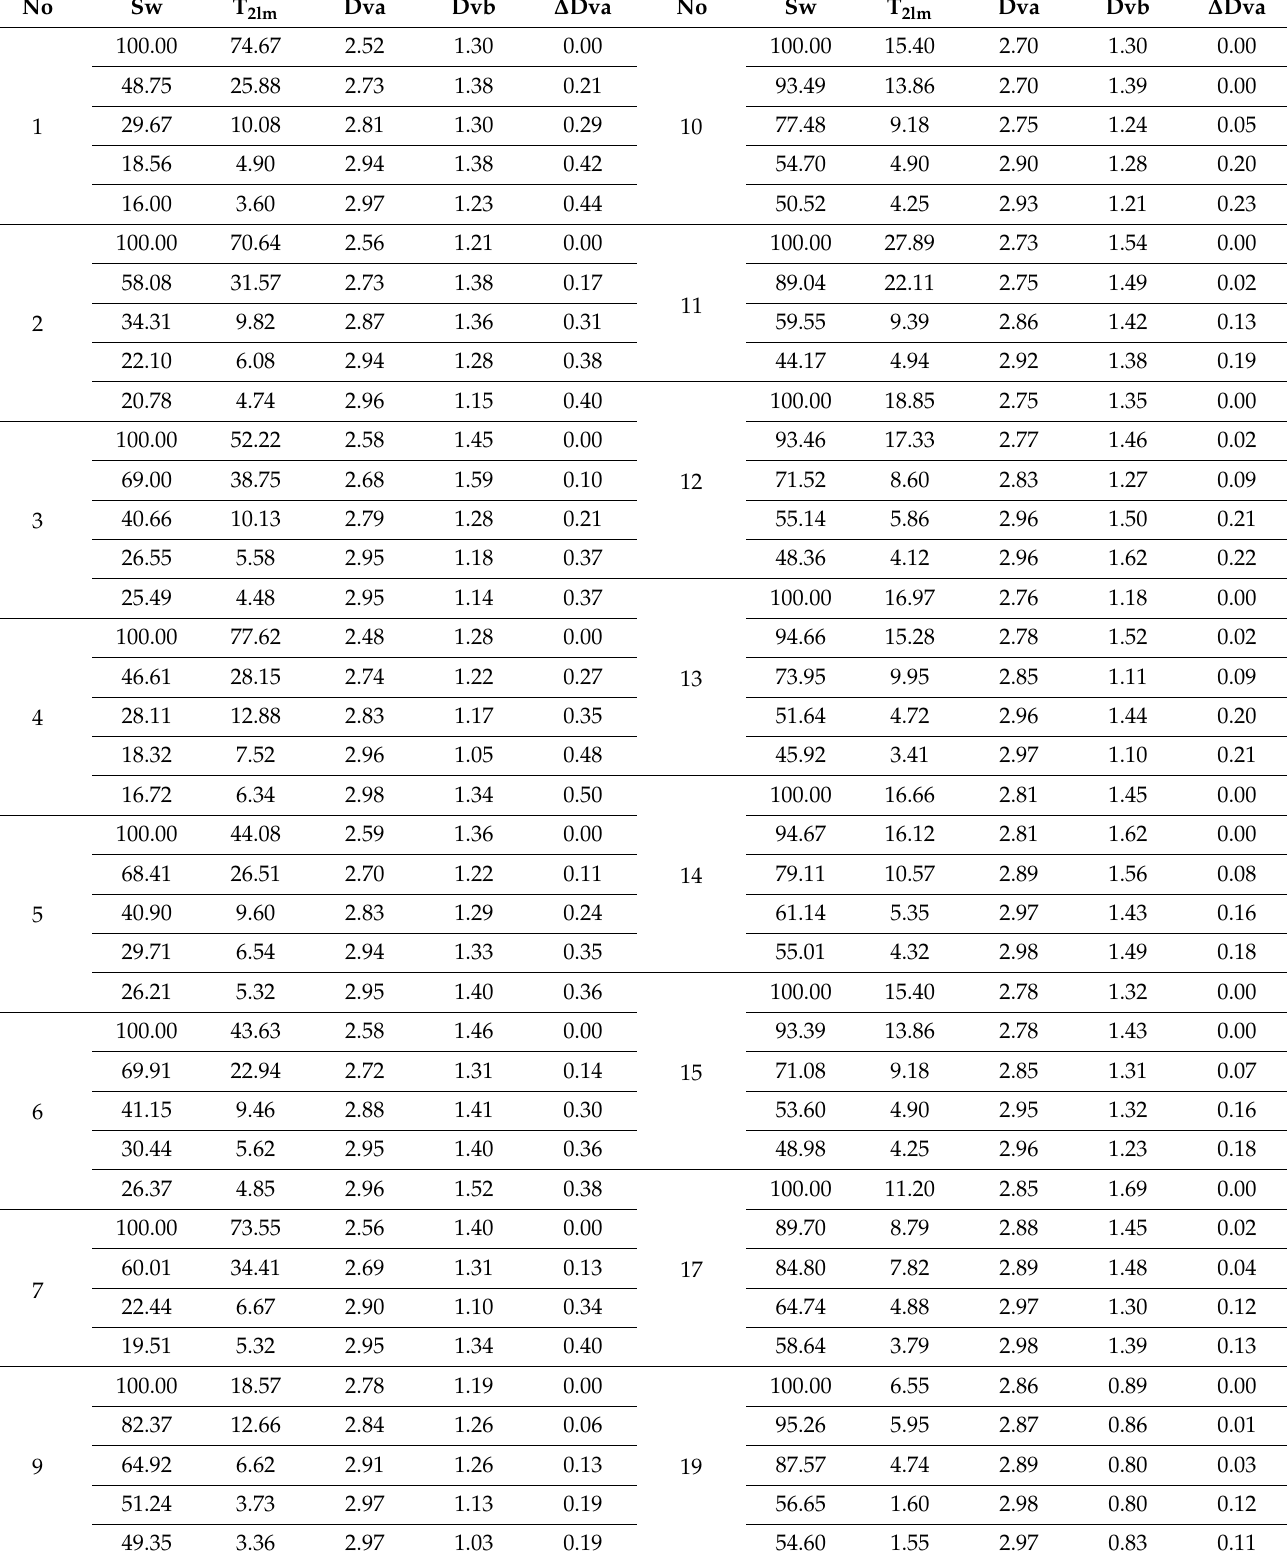
Table 2. Fractal dimensions of 16 rock samples under different water saturation